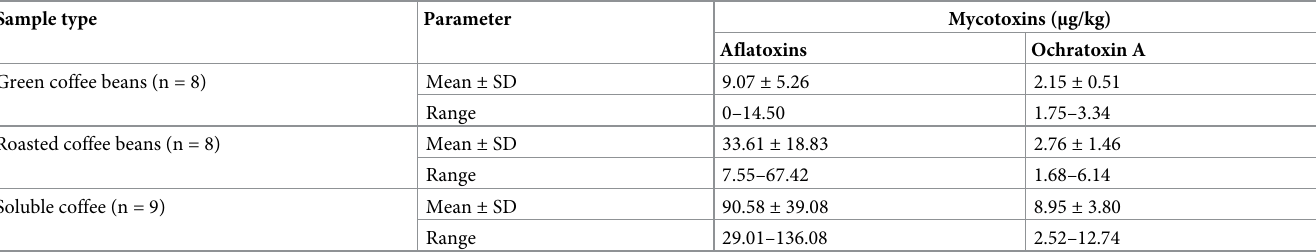
Table 1. Mycotoxins levels ( μ g/kg) in marketed coffee samples. Sample